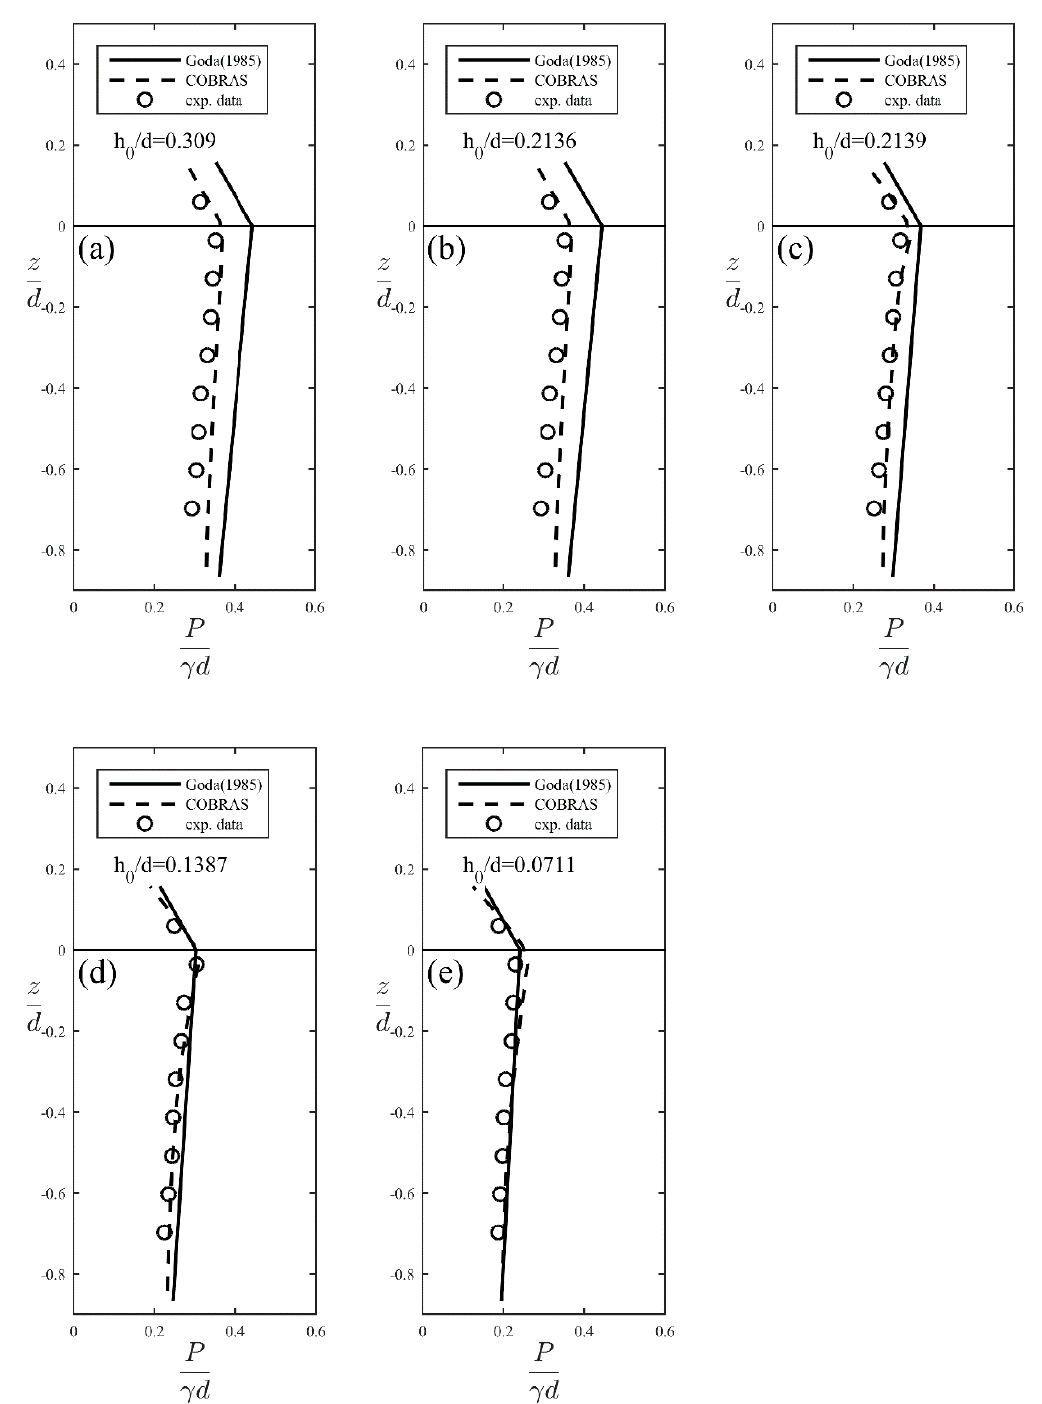
Figure 9. The comparison of maximum wave pressure along the seaward (front) face of caisson as obtained from experiments, numerical simulations, and Goda’s formula [26] for various dimensionless overtopping heights (h 0 /d). ( a ) h 0 /d=0.309; ( b ) h 0 /d=0.2136; ( c ) h 0 /d=0.2139; ( d ) h 0 /d=0.1387; ( e ) h 0 /d=0.0711.